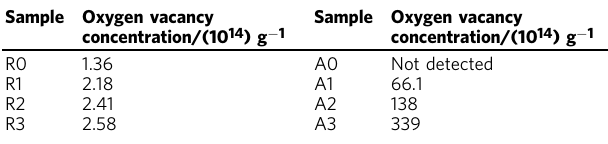
Table 2 Oxygen vacancy concentrations derived from EPR spectra of rutile and anatase